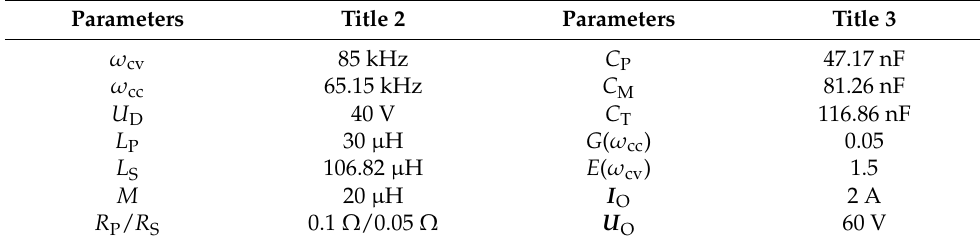
Table 2. Theoretical parameters of the proposed S/PS−compensated WPT system.